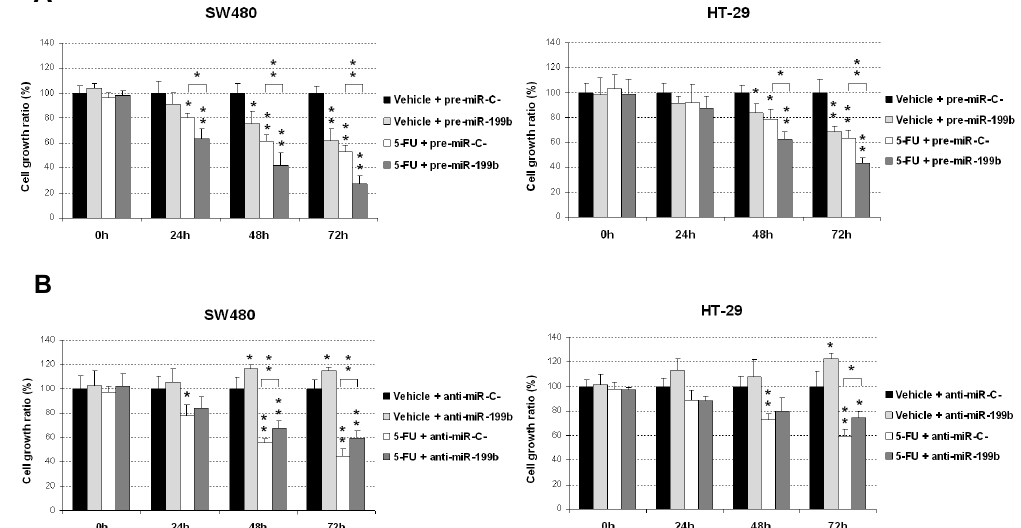
Figure 1. MiR-199b enhances sensibility to 5-fluorouracil (5-FU) treatment. MTS assay showing cell growth in SW480 and HT-29 cells treated with 5-FU (1 µM) and transfected with ( A ) pre-miR-199b or ( B ) anti-miR-199b; * p < 0.05; ** p < 0.01.